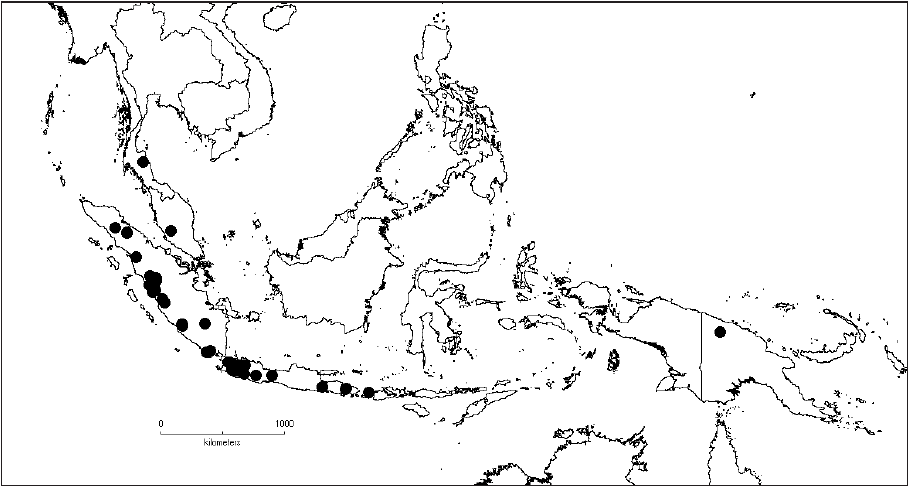
Map 12. Distribution of D. fallax ( ●